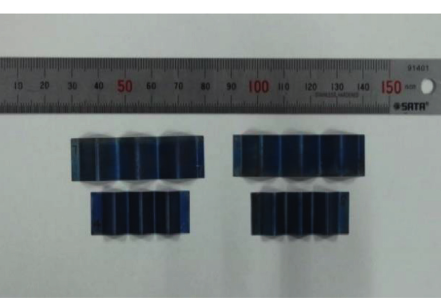
Figure 2: Corrugated samples.